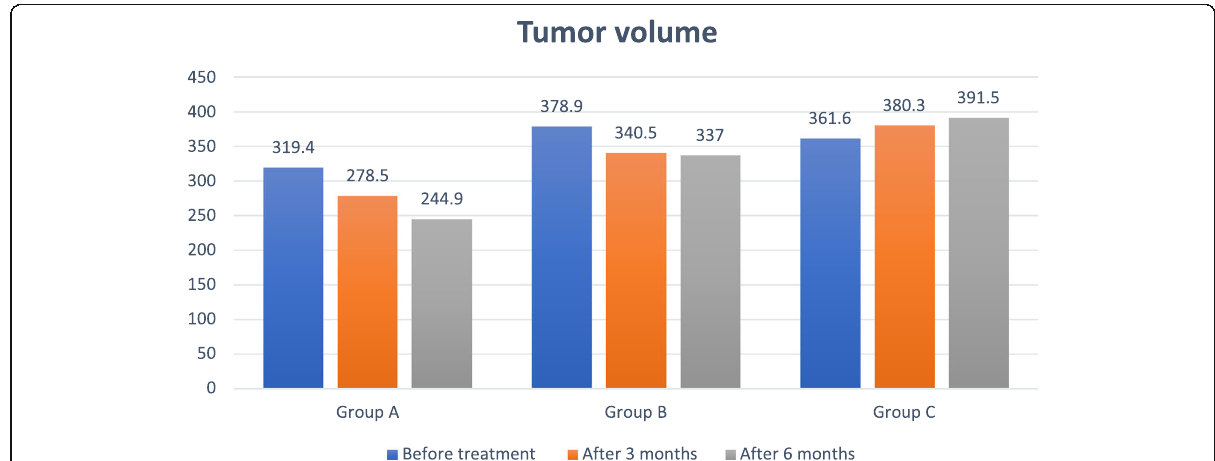
Fig. 3 Tumor volume before and after 3 and 6 months after